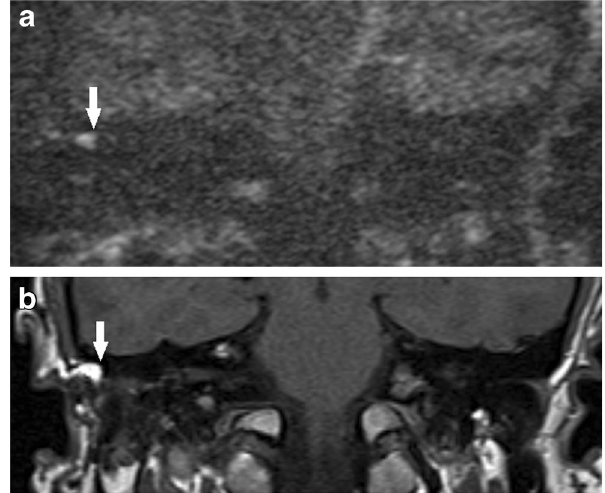
Fig. 12 Value of non-contrast enhanced T1 weighted images. False positive high DWI signal ( white arrow ) for cholesteatoma was seen on a the b1000 image. b The non-contrast enhanced T1 weighted image showed this ( white arrow ) to represent subcutaneous tissue just outside the reconstructed post-operative middle ear cleft. Otoscopic examination of the area is normal and following discussion at the clinicoradiological meeting, a follow-up DWI was arranged. This showed stable